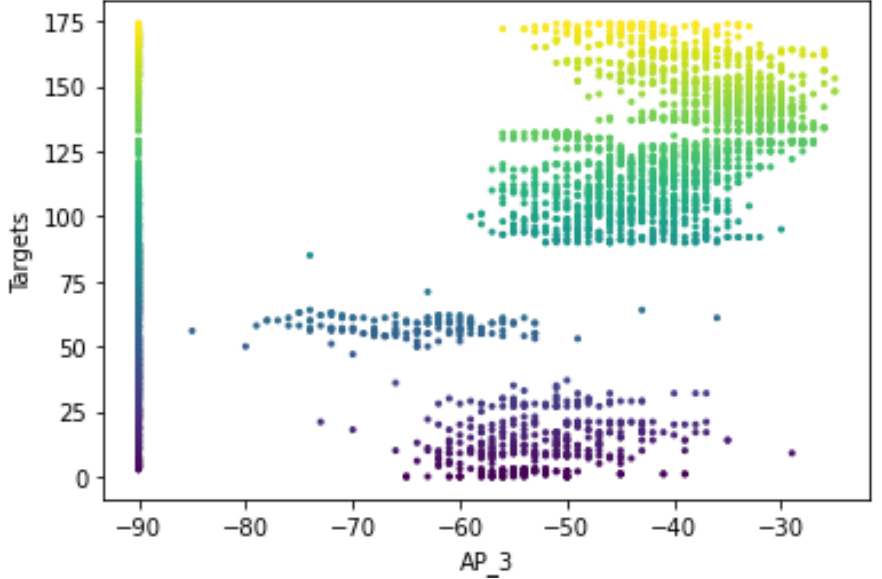
Figure 17. Distributions of RSS for Wi-Fi-AP3 with their corresponding targets for dataset